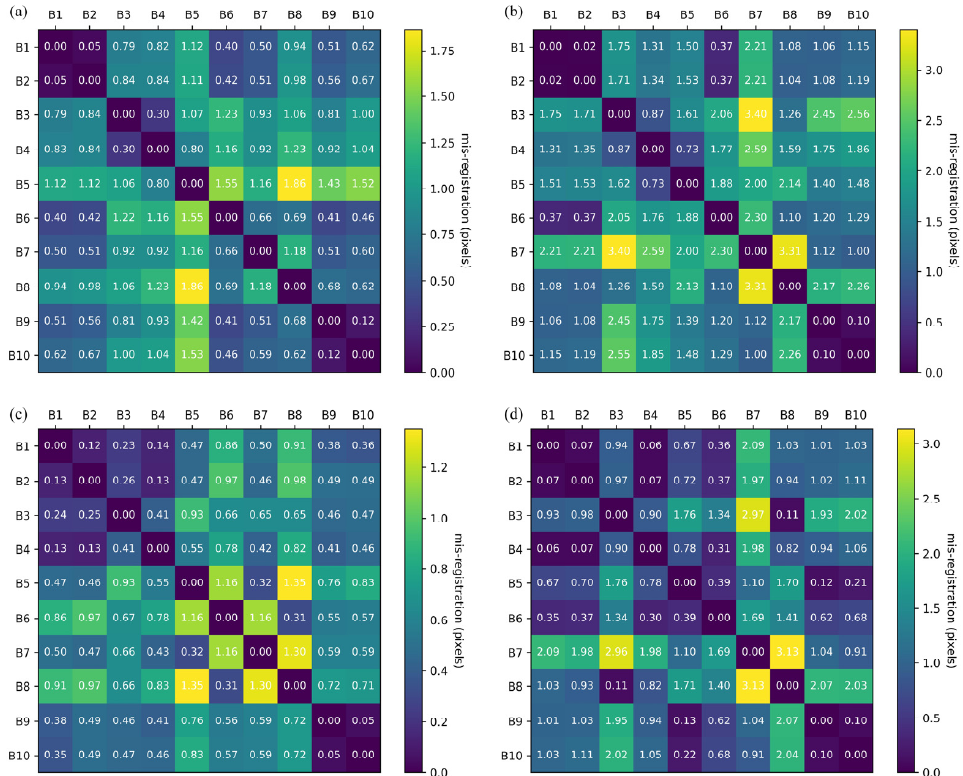
Figure 7. Band-to-band misregistration of FY1C/1D before co-registration. ( a ) the misregistration of FY-1D in the along-scan direction. ( b ) the misregistration of FY-1D in the along-track direction. ( c ) the misregistration of FY-1C in the along-scan direction. ( d ) the misregistration of FY-1C in the along-track direction.